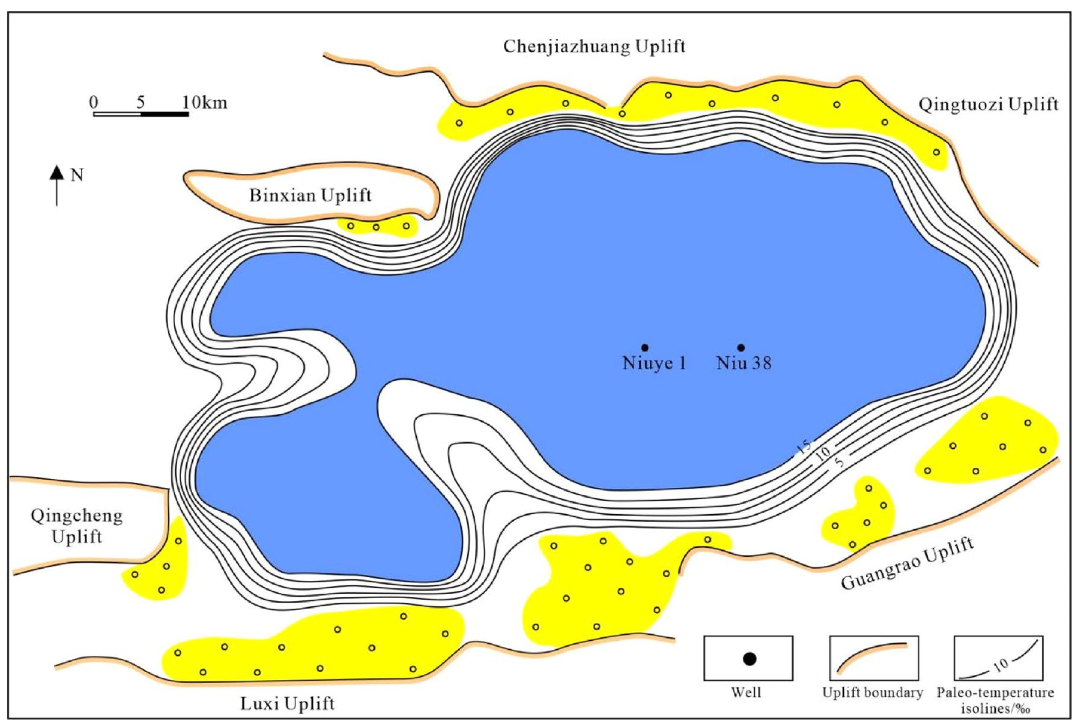
Fig. 3 Paleosalinity contour map of the Shahejie Formation in the Dongying Sag